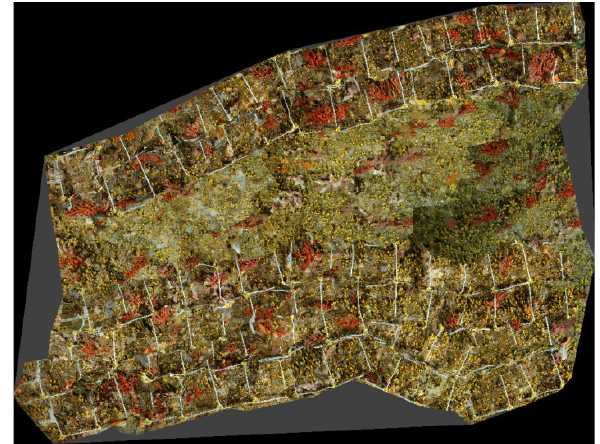
Figure 2. Permanent plots, with fixed and covered targets in Scandola,